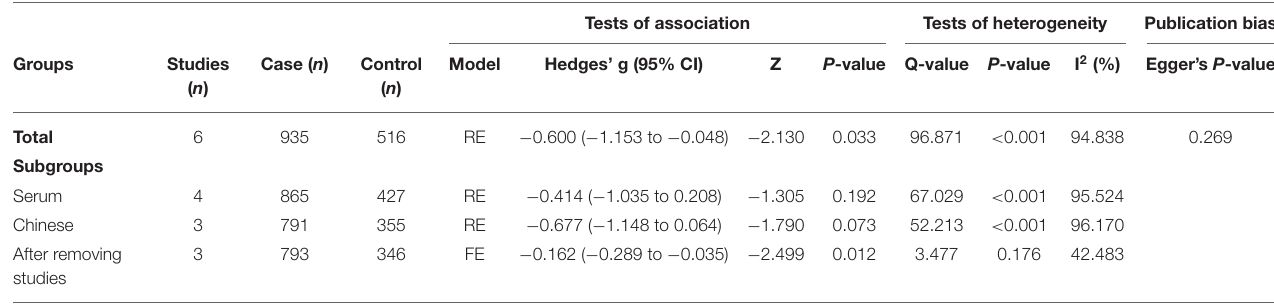
TABLE 2 | Summary of meta-analysis